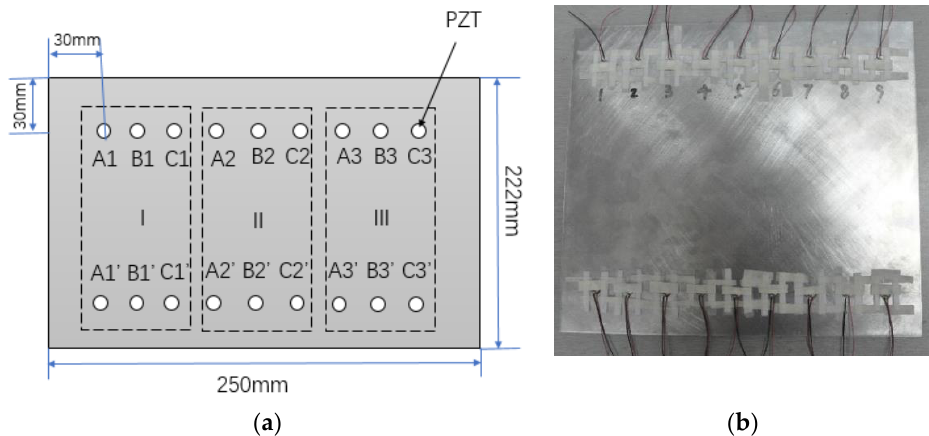
Figure 4. Schematic of piezoelectric elements on Al 2024-T3 plates: ( a ) the design drawing: the adhesive thickness of zone I is 0.01 mm, that of zone II is 0.05 mm, and that of zone III is 0.12 mm; Ai: AW106, Bi: E-30CL, Ci: E-120HP; ( b ) actual diagram.